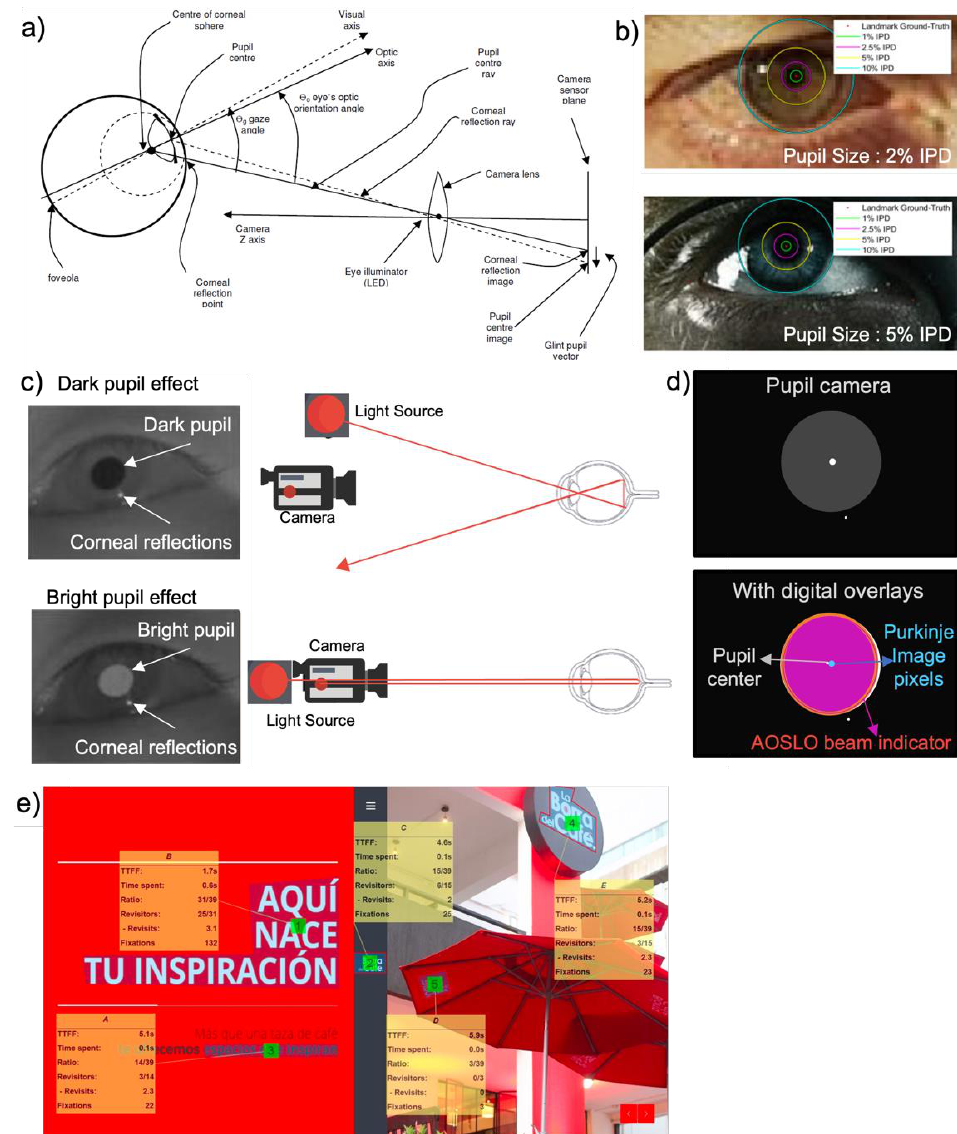
Figure 12. Eye gaze and movement estimation. ( a ) Optical metric for pupil center corneal reflection (PCCR) eye-gaze-tracking technology (Reproduced under terms of the CC-BY license [72]. Copy- right 2013, the Authors. Published by ProQuest LLC). ( b ) Pupil images indicating inter-pupillary distance with two different landmark proportion (Reprinted under terms of the CC-BY license [148].